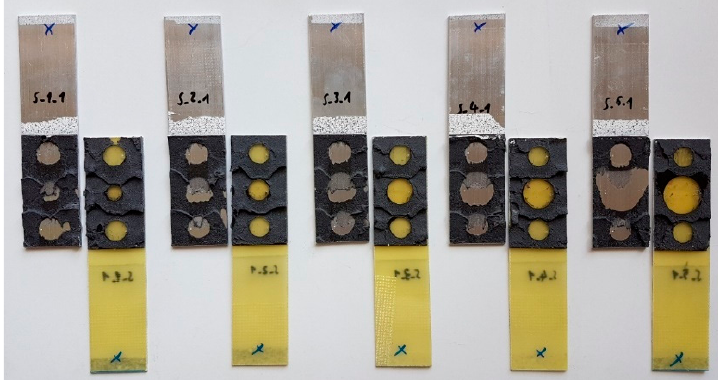
Figure 12. Triple-adhesive group “S” samples after damage.